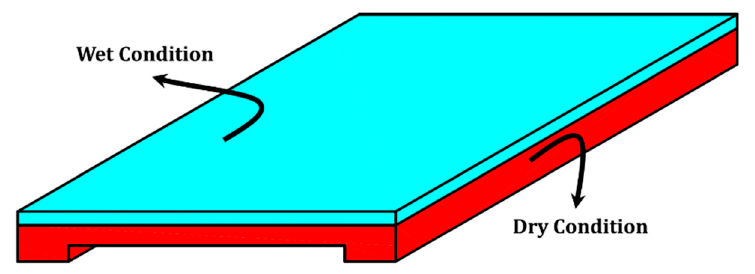
Figure 7. Standardized states for stagnant water studied cases.